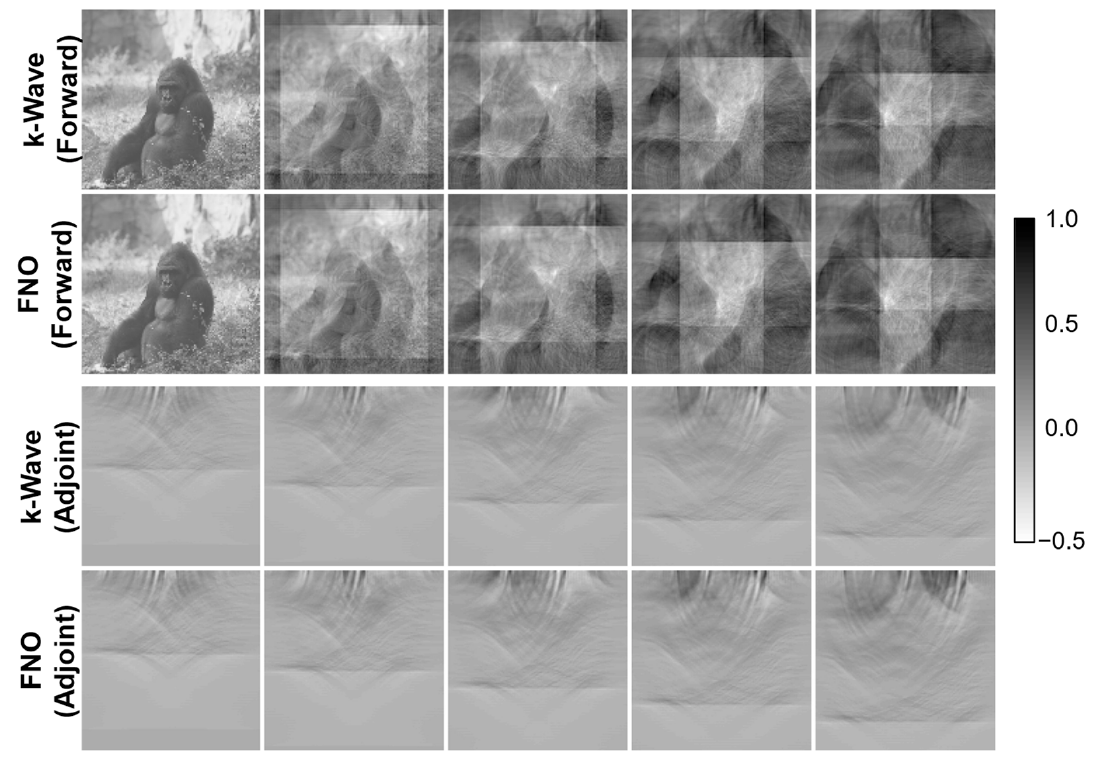
Figure 8. Simulations shown are for a 128 × 128 computation grid. ( Top ) Comparison between FNO and k-Wave forward simulations at t = [1, 40, 80, 120, 160] time steps. ( Bottom ) Comparison between FNO and k-Wave adjoint simulation t = [200, 220, 240, 260, 280] time steps. The input to both adjoint simulations was sensor data sampled with a linear array from the k-Wave forward simulation.